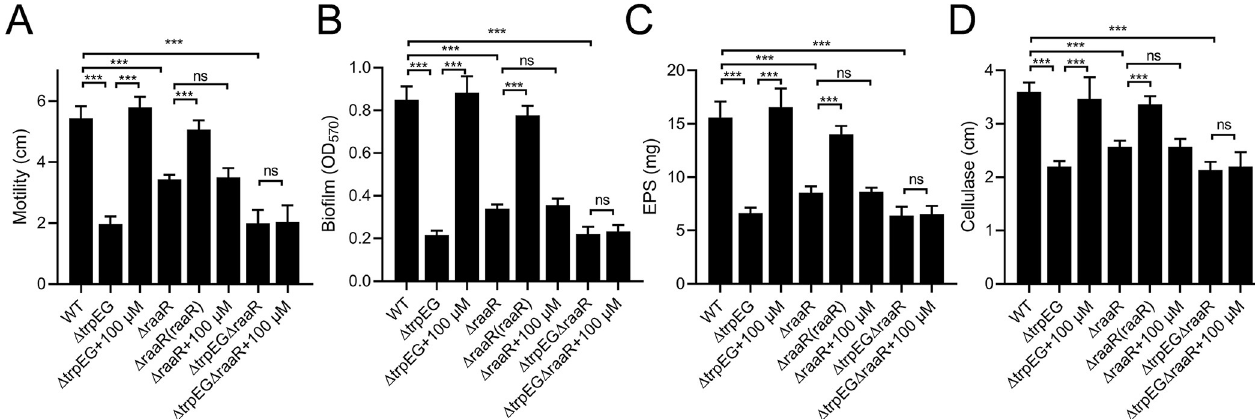
Fig 2. Effects of raaR on the anthranilic acid-regulated motility (A), biofilm formation (B), EPS production (C) and cellulase production (D) in R . solanacearum GMI1000. The data are the means ± standard deviations of three independent experiments. ��� p < 0.001 (unpaired t -test).